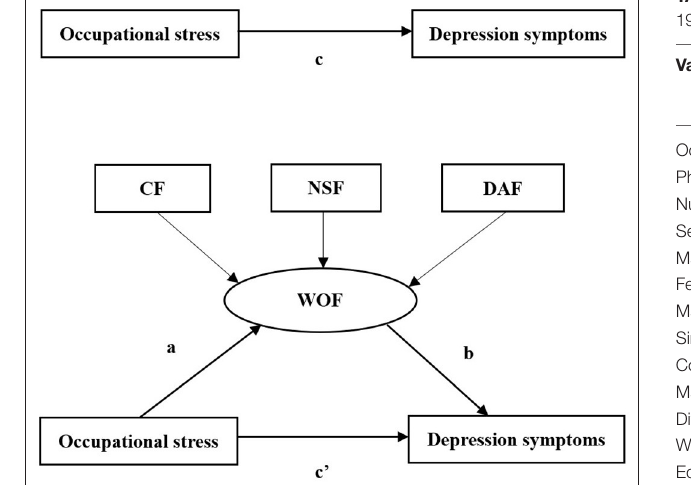
FIGURE 2 | The conceptional model on the mediating role of WOF on the association between occupational stress and depression symptoms. WOF, worker occupation fit.